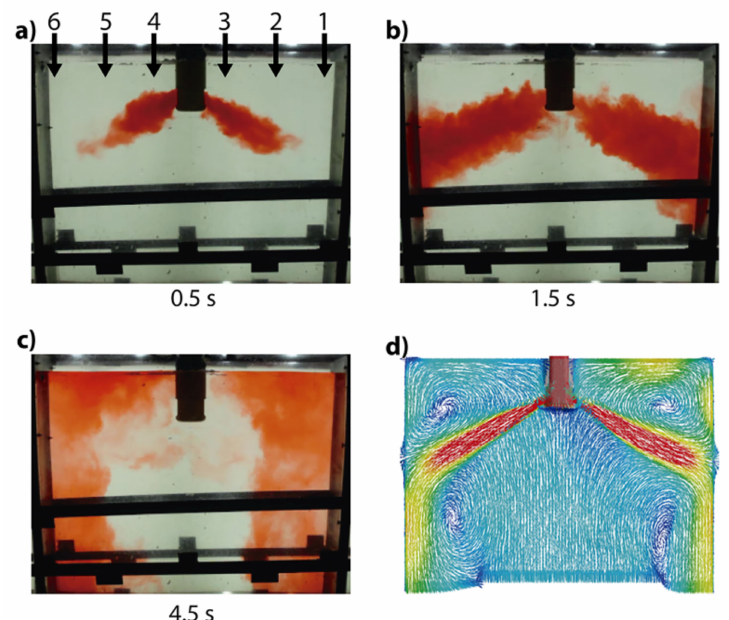
Figure 8. Tracer mixing in the mold model using nozzle B without clogging. ( a ) A total of 0.5 s after tracer injection; the numbers indicate the positions of the sensors. ( b ) A total of 1.5 s after tracer injection. ( c ) A total of 4.5 s after tracer injection. ( d ) Numerical velocity